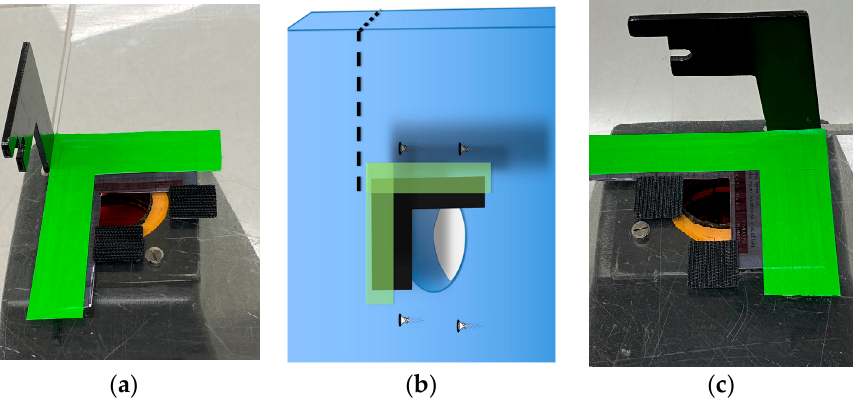
Figure 2. Details of adapting the camera mount for cell phones or iPad. Because of the large size of the camera hole, we placed an L-shaped piece of heavy black paper over the top right corner of the hole and secured the paper with green labeling tape. ( a ) The arm of the camera mount is positioned to the left of the green tape which is securing the black paper to the hood. ( b ) A diagram of the photo in ( a ) shows the acrylic sheet in blue, and the dotted line is the position of the cutout for the camera mount. The black paper and green tape cover three of the four fastening screws; ( c ) is a photo from a different angle.